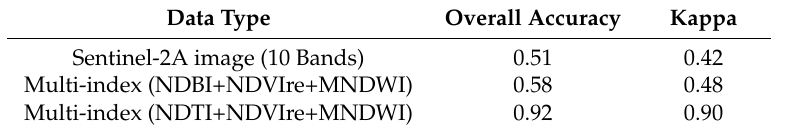
Table 7. Comparison of the overall accuracy and Kappa statistics for the Ankara region. Table 9. Comparison of the overall accuracy and Kappa statistics for the Konya region.